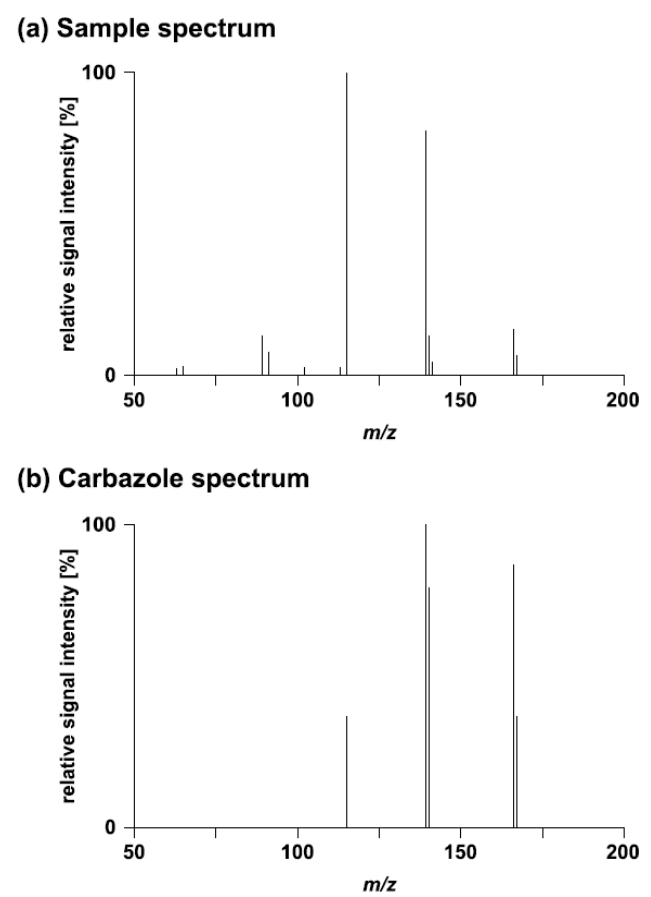
Figure 1. Comparison of ( a ) the HCD 180 sample spectrum of Challenge 14 with ( b ) the spectrum of the best matching compound and ( c ) the spectrum of the correct compound. The two reference spectra ( b,c ) were extracted from